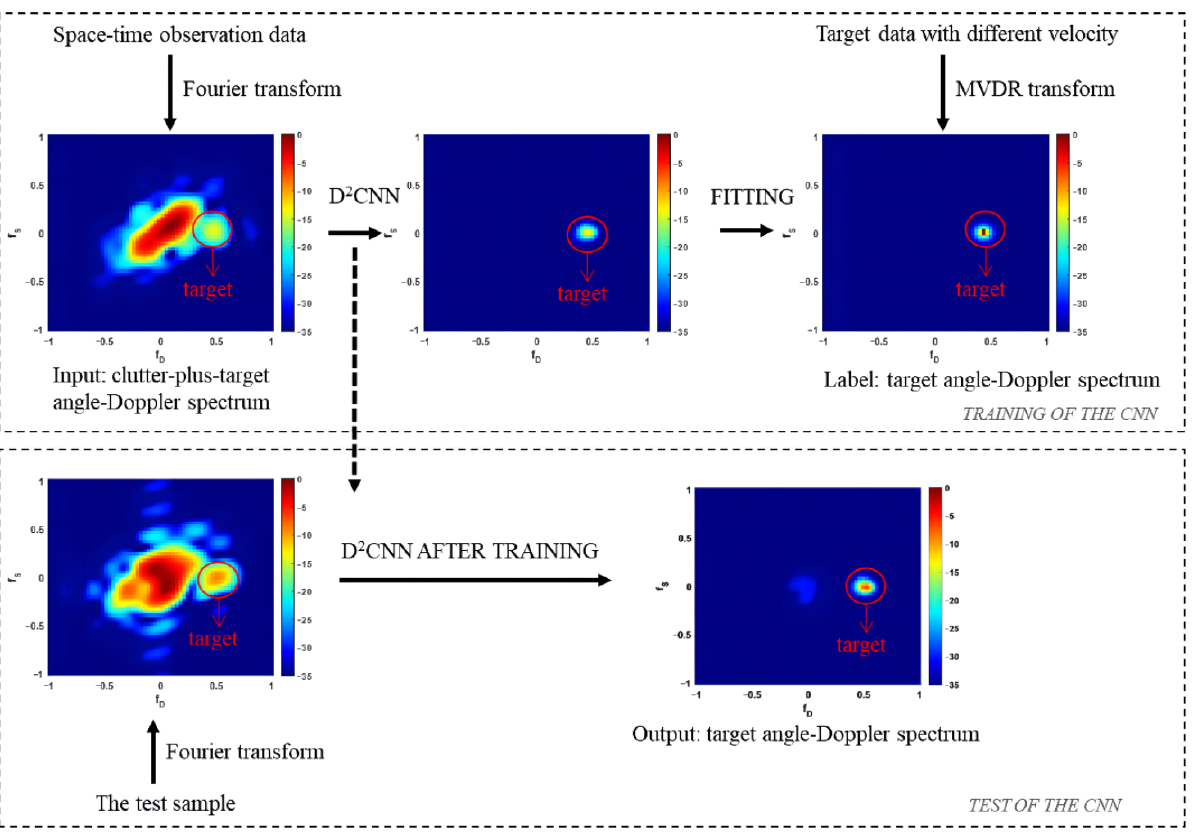
Figure 2. Deep learning framework for